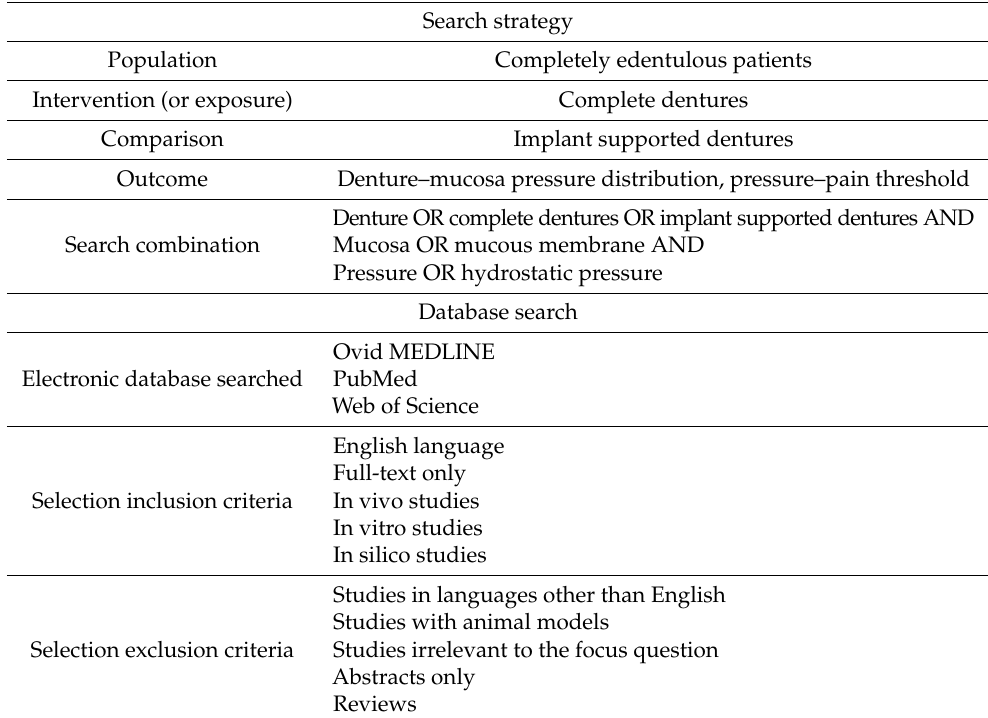
Table 1. Systematic search